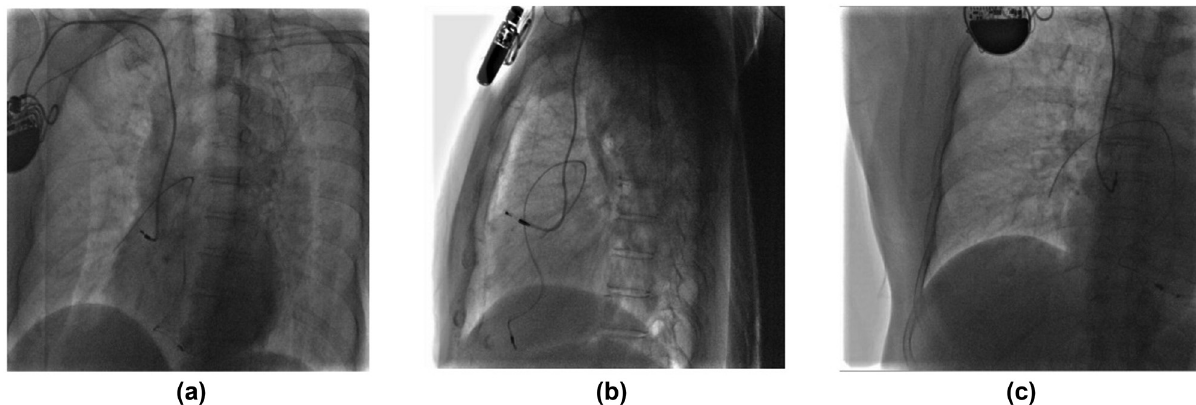
Figure 3: Chest fl uoroscopy from di ff erent body positions ( a – c ) showed atrial pacemaker rhythm and no speci fi c ST - T changes. Chest X - ray scanning had similar fi ndings as com - pared with 8 months ago, showing a complete ventricular